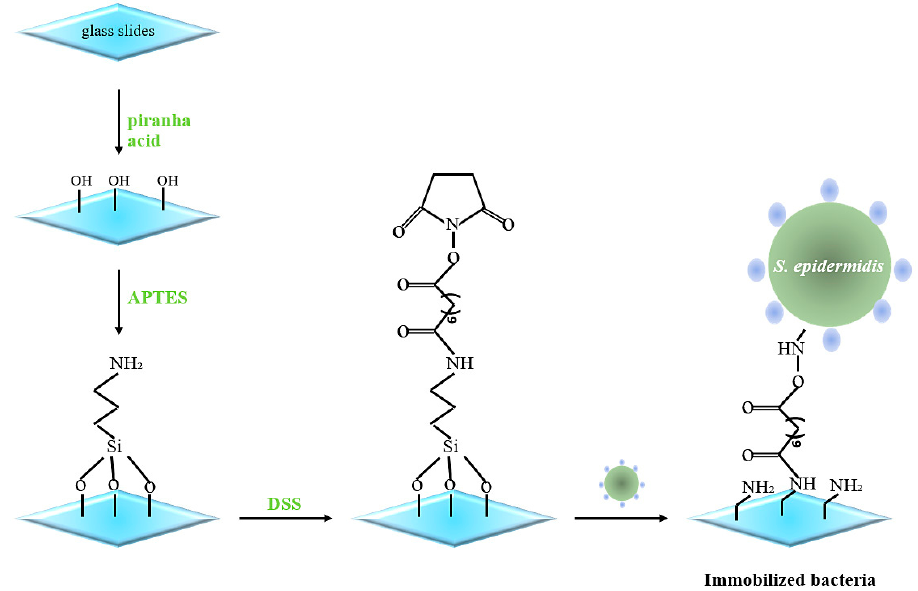
Figure 1. Schematic representation of immobilizing S. epidermidis on glass surfaces.